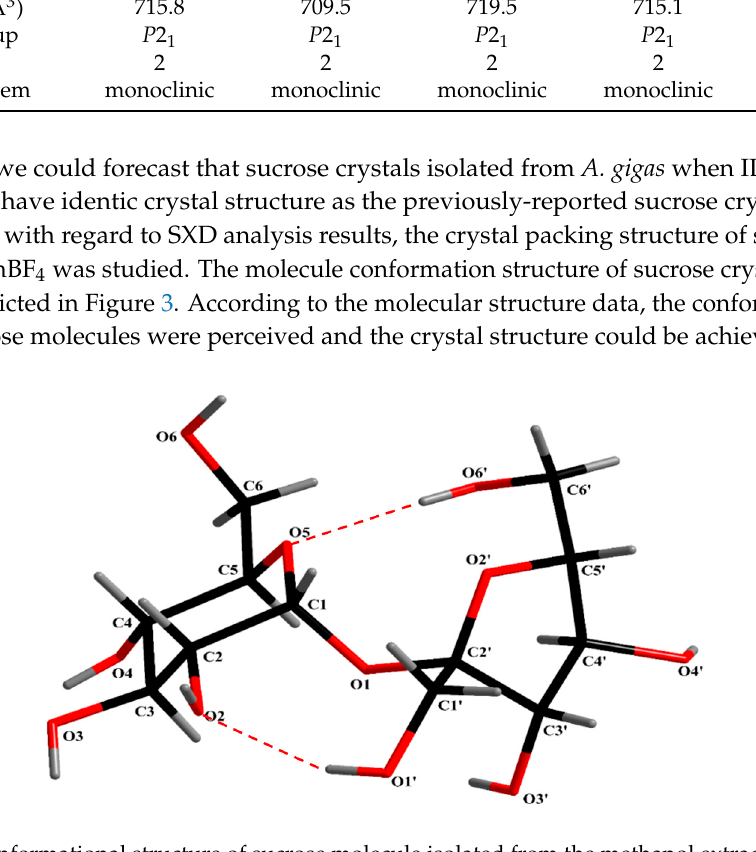
Figure 3. Conformational structure of sucrose molecule isolated from the methanol extract of A. gigas when BMImBF 4 was used as the anti-solvent.